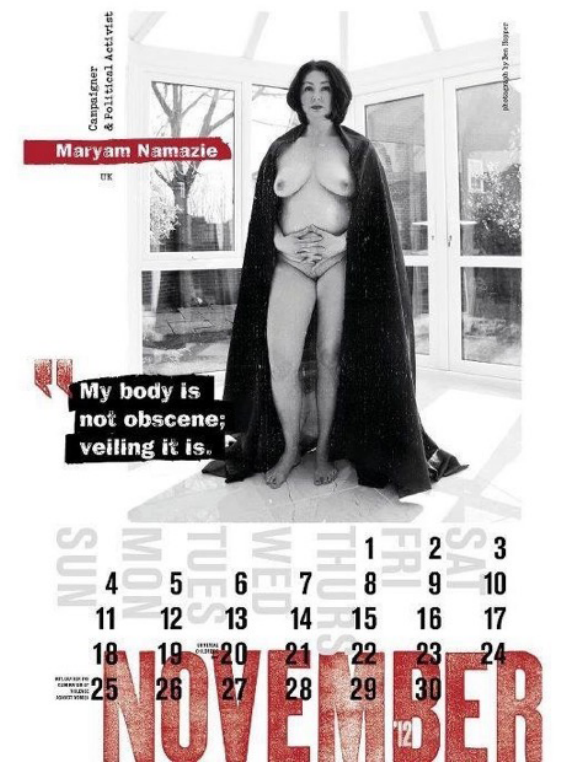
Figure 4. Secular-Feminist Maryam Namazie in her “Nude Photo Revolutionaries Calendar” published in sup- port of Elmahdy (2011).